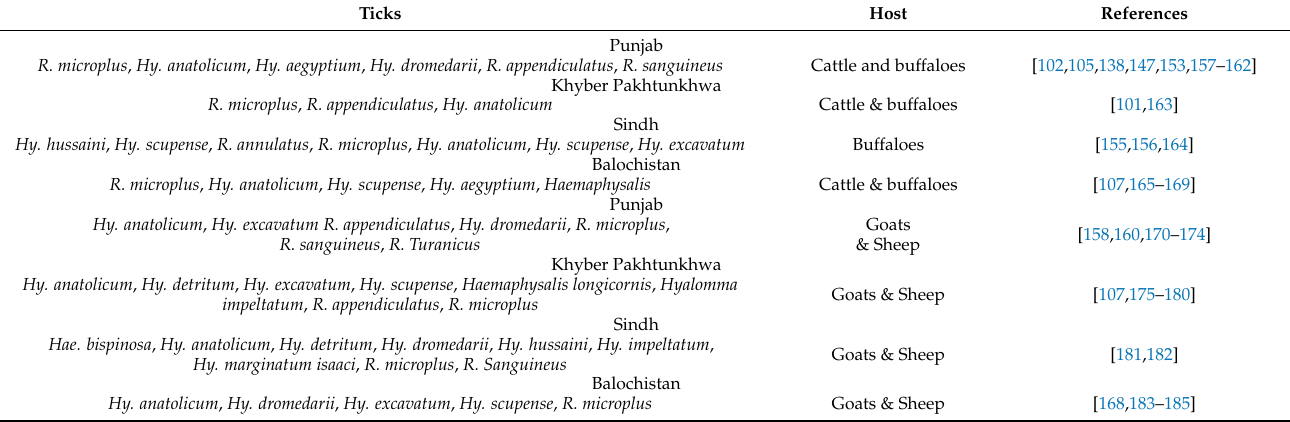
Table 5. Distribution of various tick vectors for the transmission of Theileria species in Pakistan.